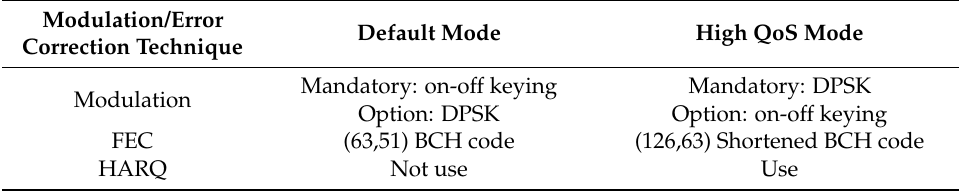
Table 2. Modulation, Error-Correcting Codes (ECC), and use of Hybrid Automatic Repeat